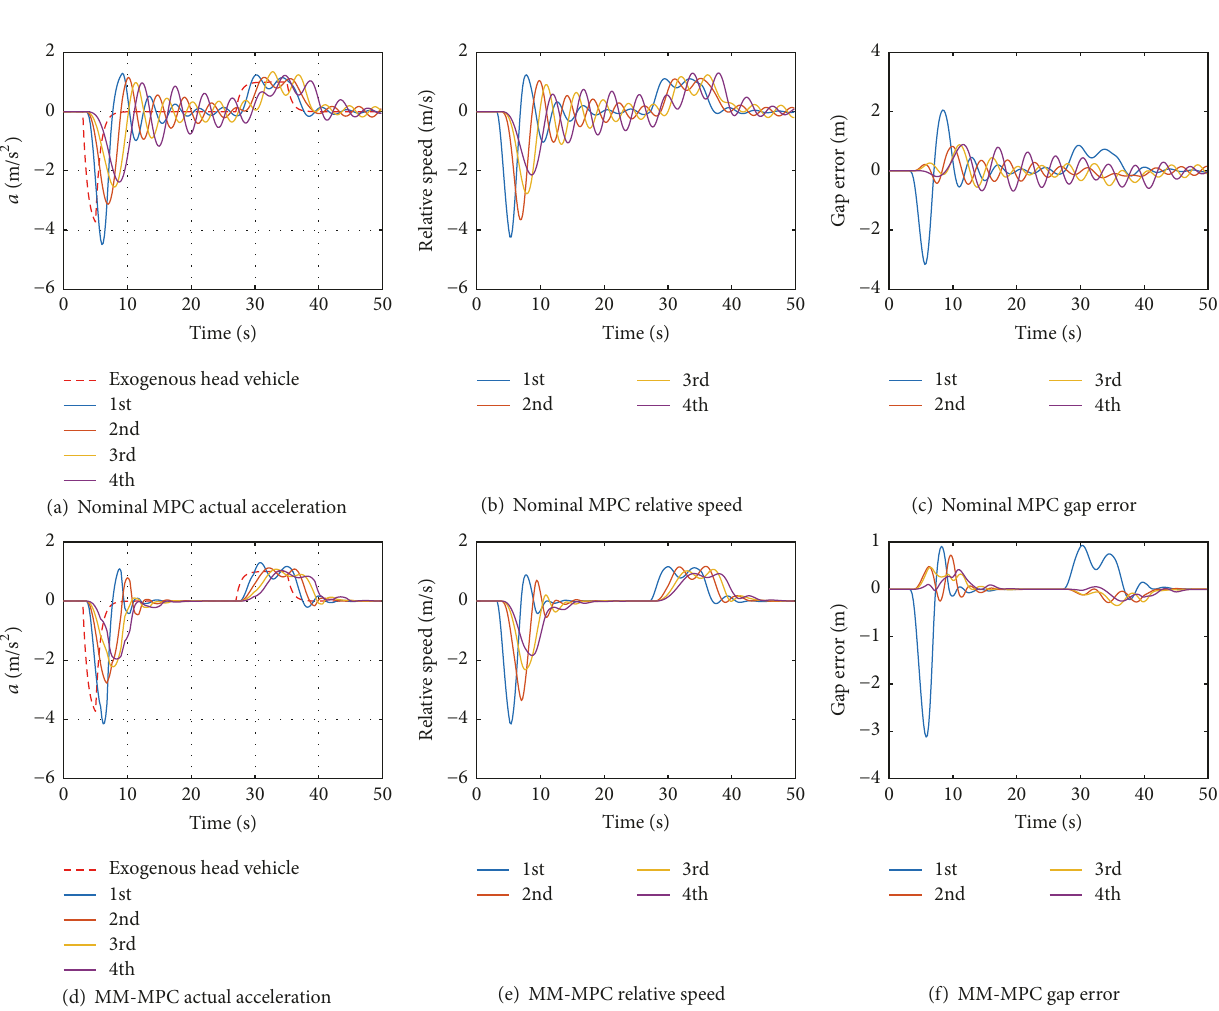
Figure 3: Comparison of nominal MPC ( 𝜏 𝐴 = 0.2 s) and MM-MPC (designed with 𝜏 𝐴 (𝑡) ∈ [0.2,0.8] s) for homogenous platooning control while actual 𝜏 𝐴 (𝑡) ∈ [0.8, 0.9] s. Table 3: Performance results: homogeneous platooning controllers.